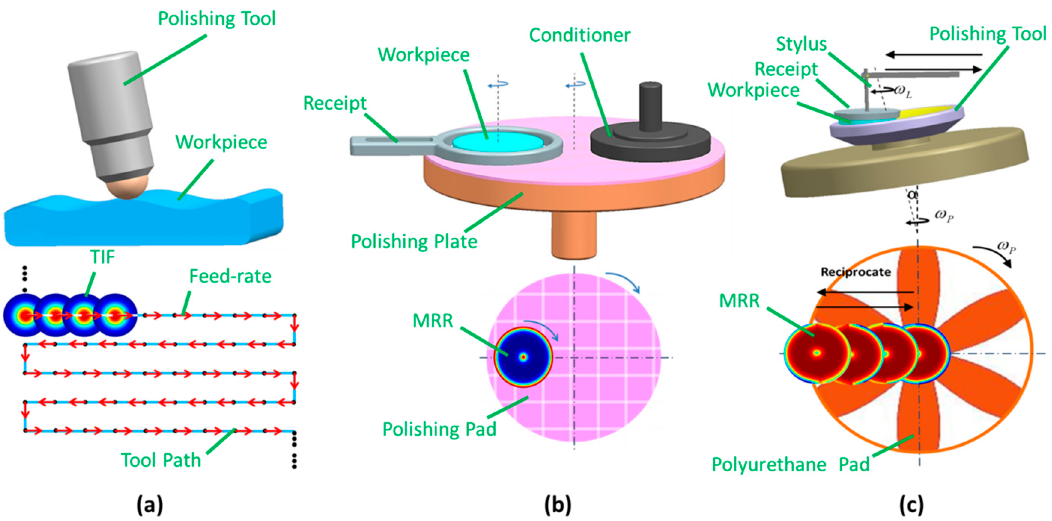
Figure 1. Illustration of different polishing processes: ( a ) bonnet polishing; ( b ) chemical mechanical polishing (CMP); ( c ) high-speed polishing.